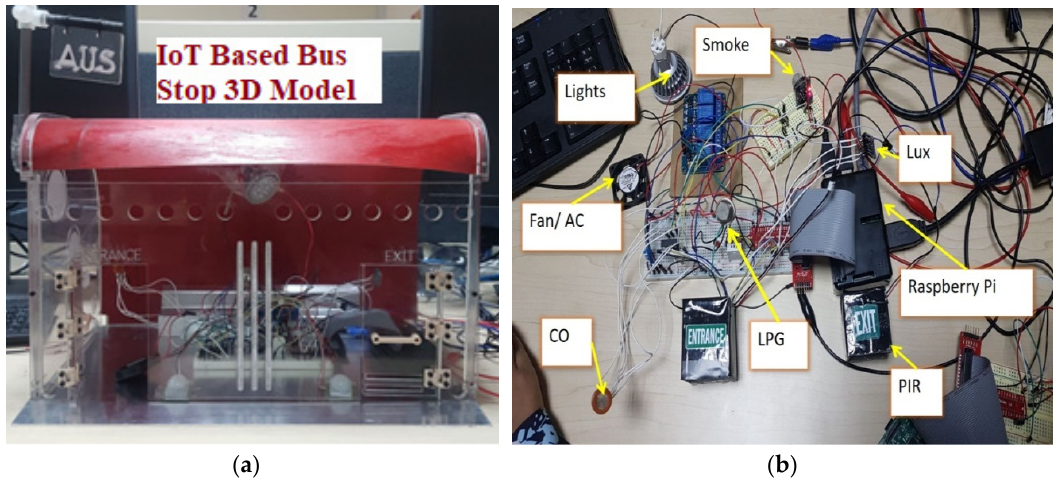
Figure 4. ( a ) IoT based bus stop 3D model; ( b ) System hardware prototype.